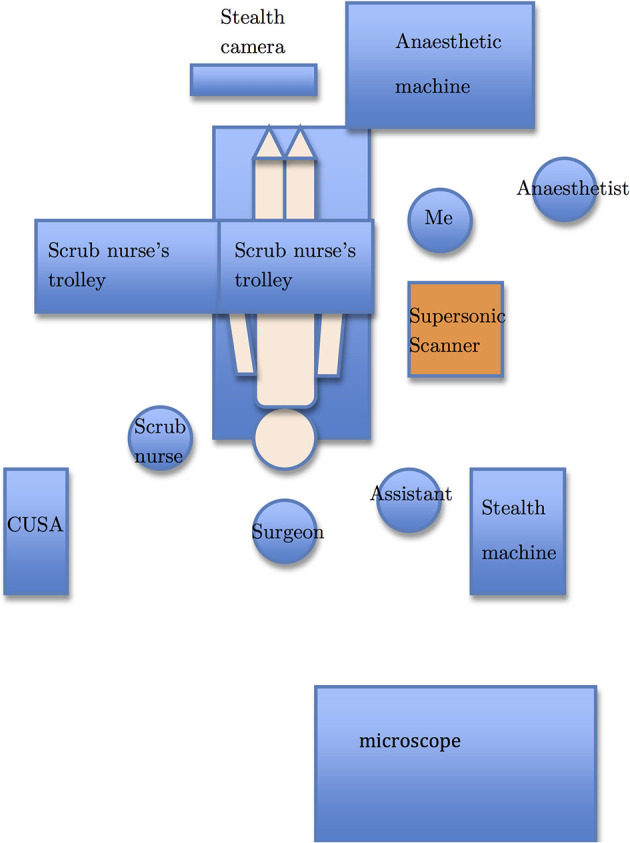
The operating room setup. The Supersonic Aixplorer® scanner (orange) is placed next to the patient body (beige) with the monitor swivelled to face the surgeon. I stand next to the scanner so that I can optimize the scanner settings as well as acquire images for this thesis.